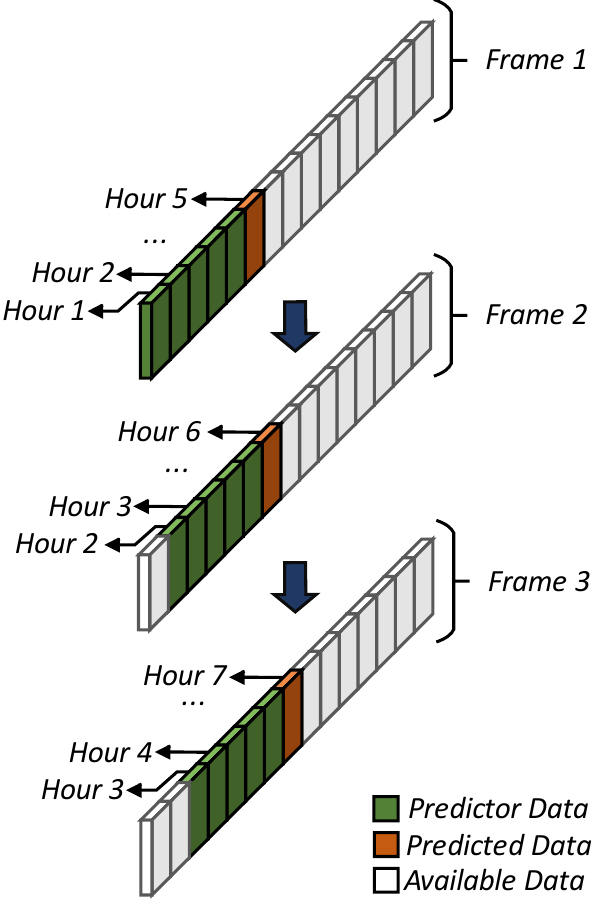
Figure 3. Illustration of sliding window method applied to the input data. The green blocks correspond to the time window ( ∆ t hours) containing the data for prediction. The orange block corresponds to the hour at which the energy demand is predicted, t p = t i + ∆ t , where t i is the initial hour of the window.